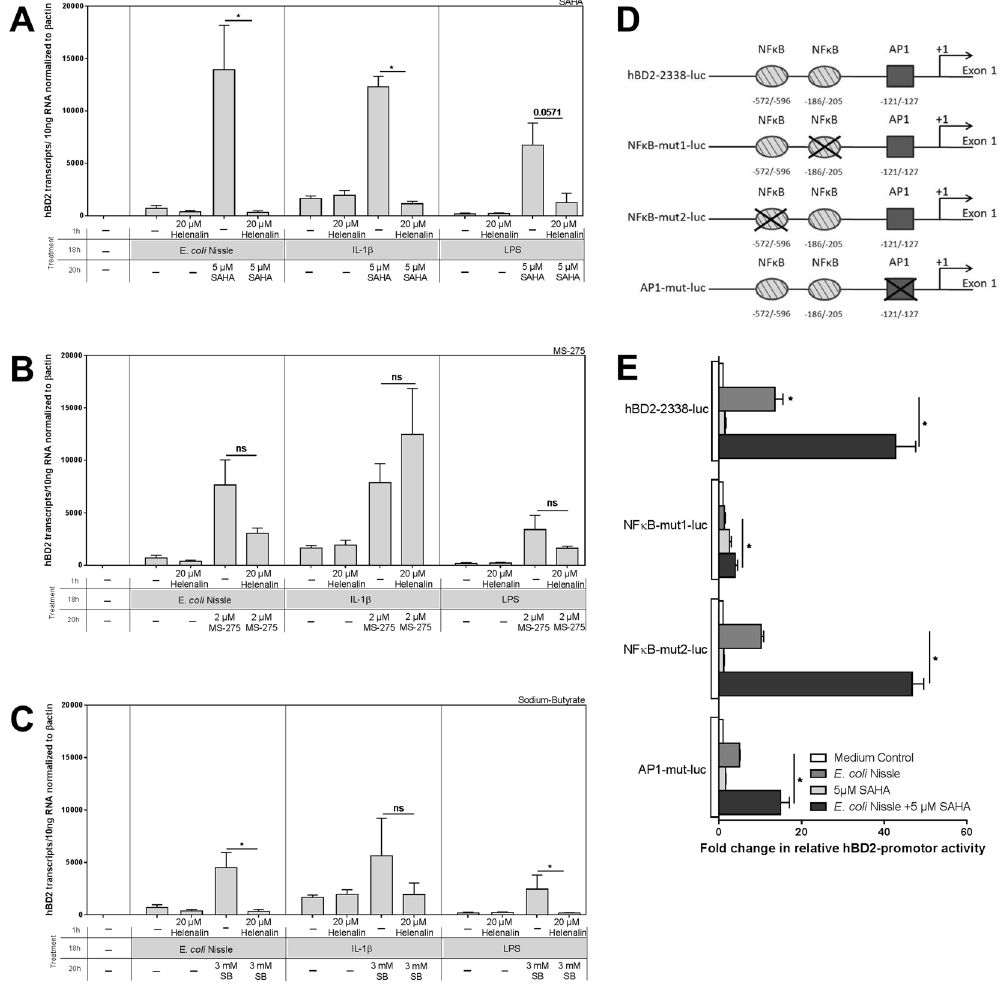
Figure 4. Pan-histone deacetylase (HDAC) inhibition enhancement of human β -defensin 2 (hBD2) expression is dependent on nuclear factor κ -light-chain-enhancer of activated B cells (NF- κ B). ( A – C ) Show the abolishment of the enhancing effect of HDAC inhibition through Helenalin in CaCo-2/TC7 cells. HBD2 mRNA induction in response to EcN (3 × 10 8 CFU/ml), IL1 β (10 ng/ml) or LPS (1 µ g/ml) alone, together with SAHA (5 µ M) ( A ) MS-275 (2 µ M) ( B ) or SB (3 mM) ( C ) and after pretreatment for 1 h with the NFkB inhibitor Helenalin (20 µ M). Represented are the results of four independent experiments carried out in biological triplicates. Shown are relative copy numbers of hBD2 per 10 ng total RNA normalized to β actin expression. * p < 0.05 evaluated by Mann-Whitney u test. ( D ) Diagram of the used hBD2 promotor constructs (bp − 2338 to − 1 linked to the luciferase gene). Two NF- κ B binding sites and one AP1 binding site are marked relative